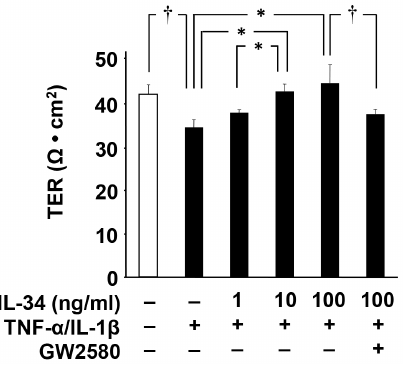
Fig. 3. IL-34 restores damaged BBB integrity. MBEC4 cells were treated with TNF- a (20 ng/ml) and IL-1 b (20 ng/ml) in the presence of IL-34 (0–100 ng/ml) and GW2580 (1 m mol/l). TER of MBEC4 cell monolayer was measured after a 24-h incubation. Values are means ¡ SEM (n 5 5). *, p , 0.05; { , p , 0.01.